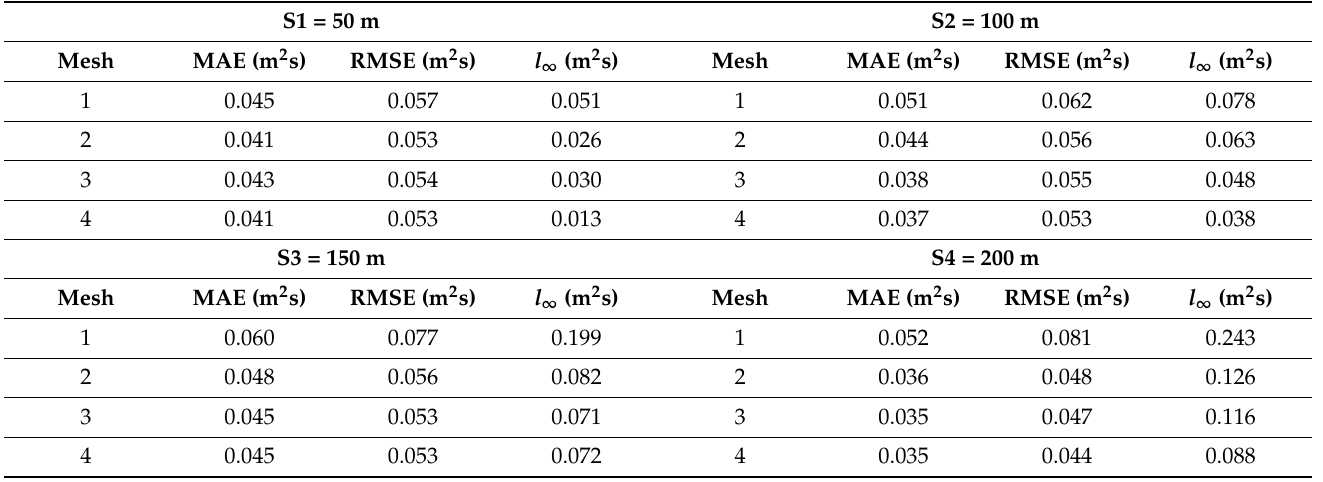
Table 7. MAE, RMSE and l ∞ norm for the spectral densities for the gauges S1, S2, S3 and